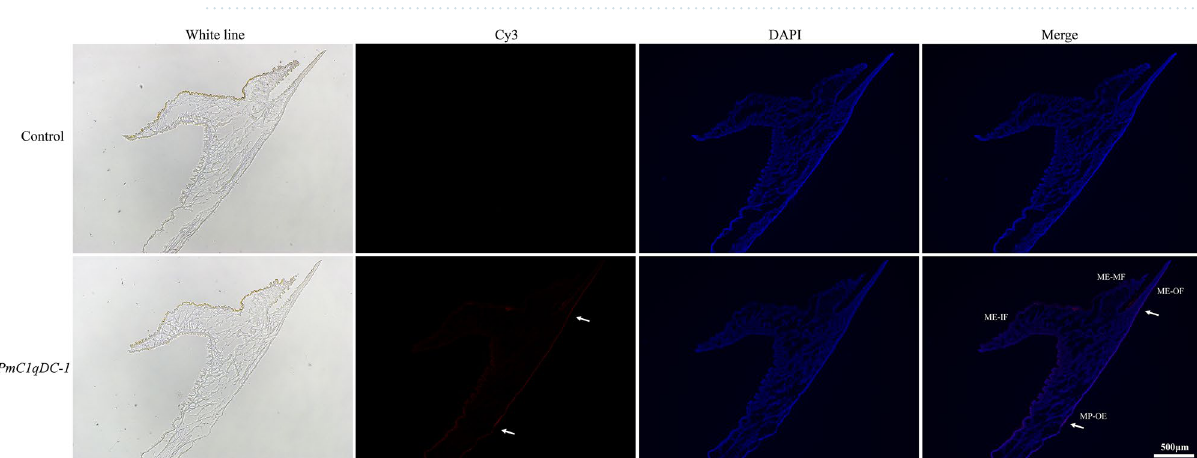
Figure 3. Expression pattern of PmC1qDC-1 in different tissues and larvae development. ( a ) Expression pattern of PmC1qDC-1 in different tissues. A adductor muscle, HO hemocytes, GI gill, MC mantle central, MP mantle pallial, F foot, ME mantle edge. ( b ) Expression pattern of PmC1qDC-1 in larvae development. E egg, Fe fertilization, B blastula, G glastula, T trochophore stage, D D-stage larvae, DF D-stage larvae before feeding, EU early umbo larvae, EL eyed larvae, S spat, J juveniles. The averages of the groups with the different lower-case letters (a, b, c, d) are significantly different (P < 0.05). The averages of the groups with the same lower-case letters (a, b, c, d) are not significantly different (P > 0.05).